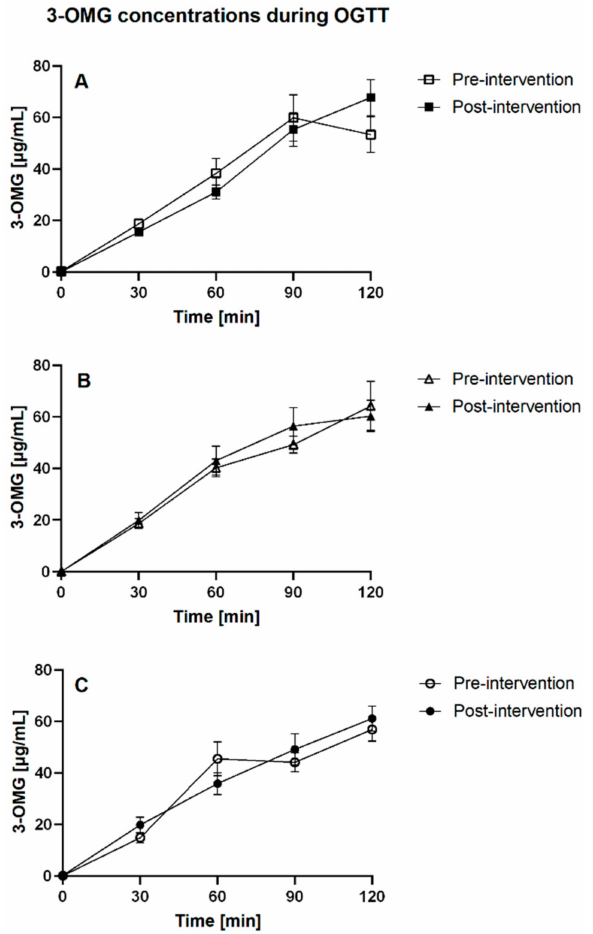
Figure 1. 3-OMG concentrations before and after the intervention period in ( A ) the control group, ( B ) the erythritol group, and ( C ) the xylitol group. Data are displayed as mean ± SEM; OGTT: oral glucose tolerance test.